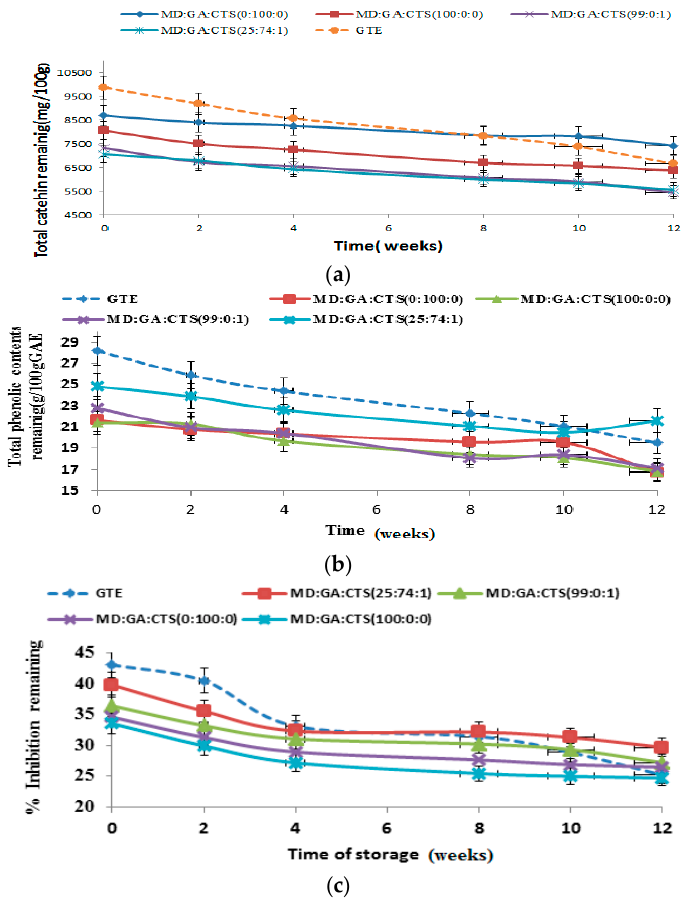
Figure 7. Storage study of green tea microparticles powder at 40 °C for 12 weeks showing ( a ) stability of total catechin in powder; ( b ) total phenolic content (TPC); ( c ) and antioxidant activity of microparticles. All values are means of three replicate sample determinations ± SD. (MD—maltodextrin, GA—gum arabic, CTS—chitosan).